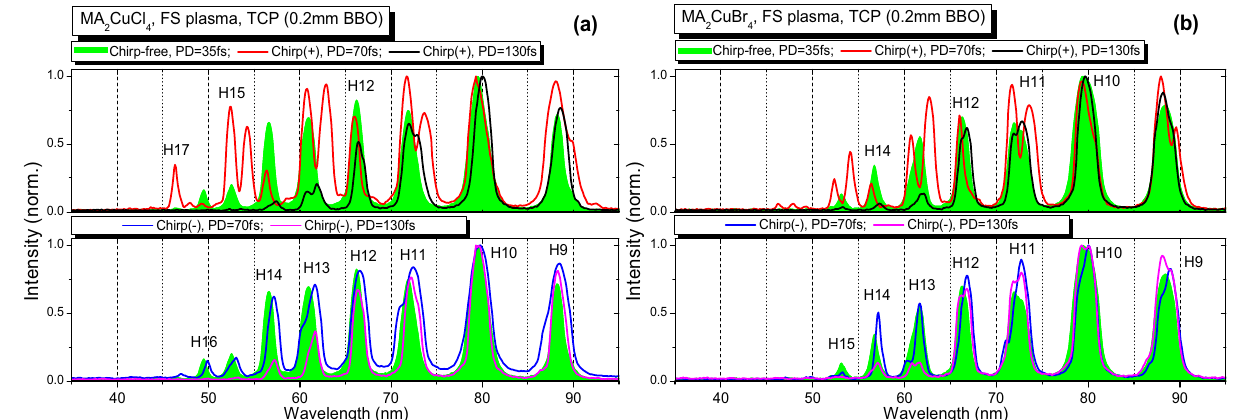
Figure 2. Harmonic spectra in the case of TCP scheme generated in two LIPs produced by FS HP. ( a ) HHG in MA 2 CuCl 4 LIP. ( b ) HHG in MA 2 CuBr 4 LIP. The harmonic spectra depending on the pulse duration and the sign of chirp are shown. Green filled profiles of harmonics correspond to the chirp-free 35 fs PP (Chirp- free, PD = 35 fs), red curves correspond to the positively chirped 70 fs PP (Chirp( +), PD = 70 fs), blue curves correspond to the negatively chirped 70 fs PP (Chirp(-), PD = 70 fs), black curves correspond to the positively chirped 130 fs PP (Chirp( +), PD = 130 fs), and purple curves correspond to the negatively chirped 130 fs PP (Chirp(-), PD = 130